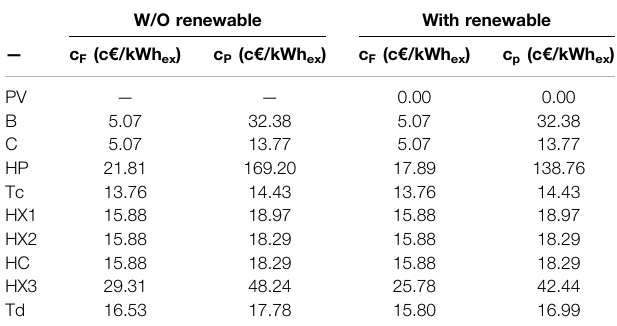
TABLE 5 | Exergoeconomic results without and with renewable electricity. W/O renewable With renewable